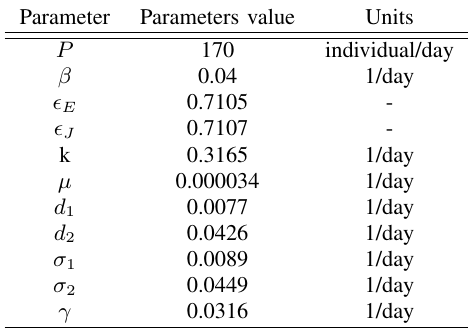
TABLE III: Model parameter for Riyadh, the case R = 1 . 0045 . c